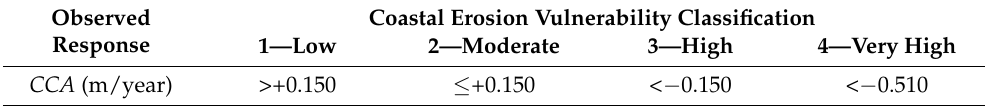
Table 4. Coastal erosion vulnerability